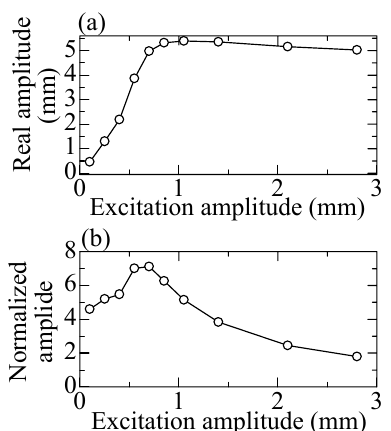
Fig. 12 Dependence of (a) ξ and (b) phase angle on the excitation amplitude.